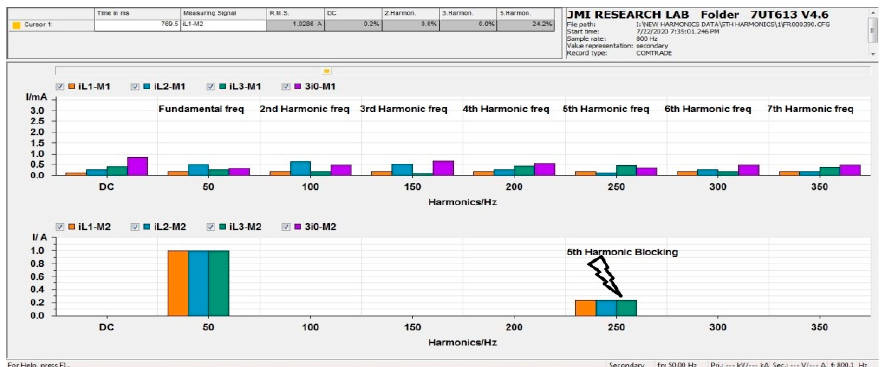
Figure 26. 5th HB at 1000 mA Rated current & 38% of Inrush current condition.